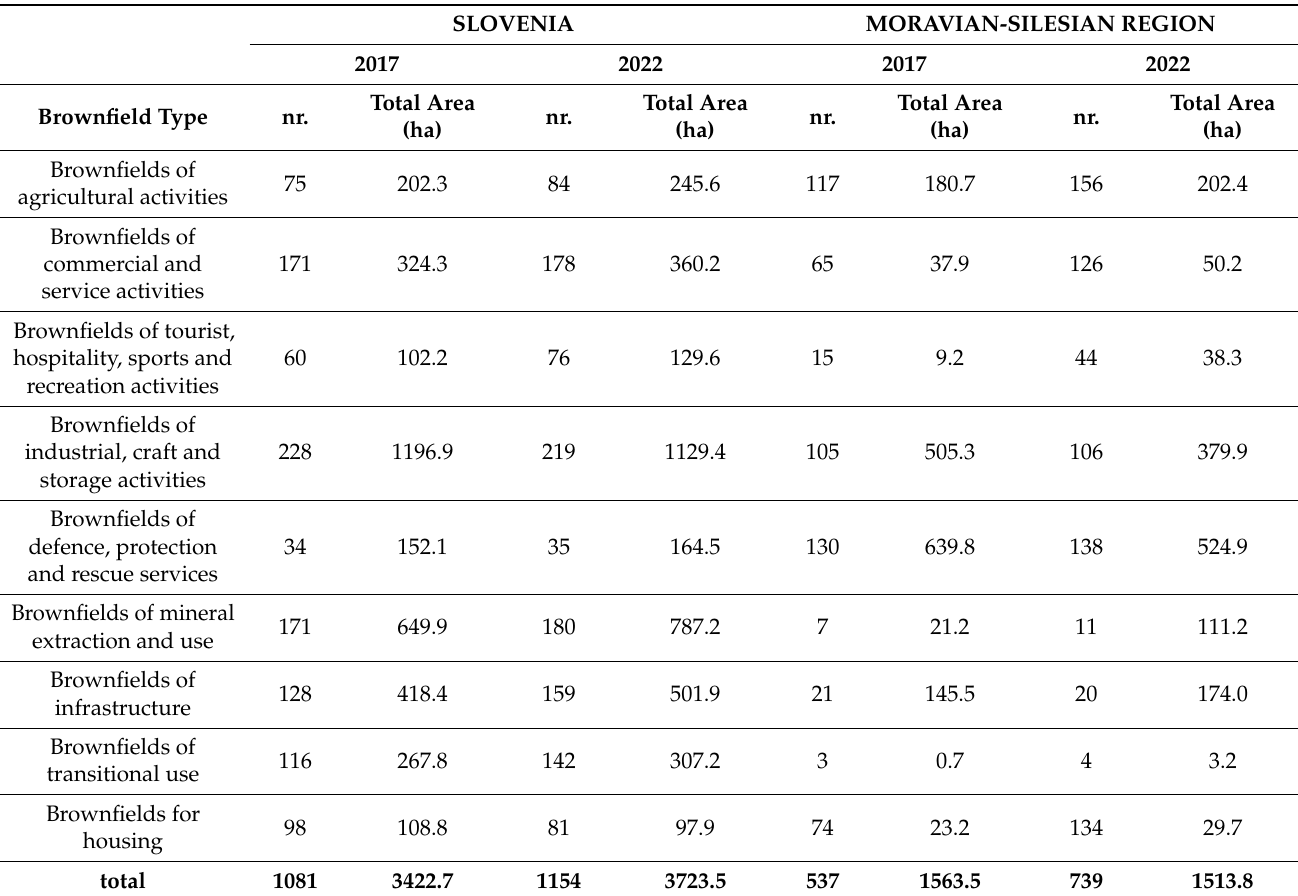
Table 3. Number and total area of brownfields in Slovenia and the Moravian-Silesian region in 2017 and 2022 (by brownfield